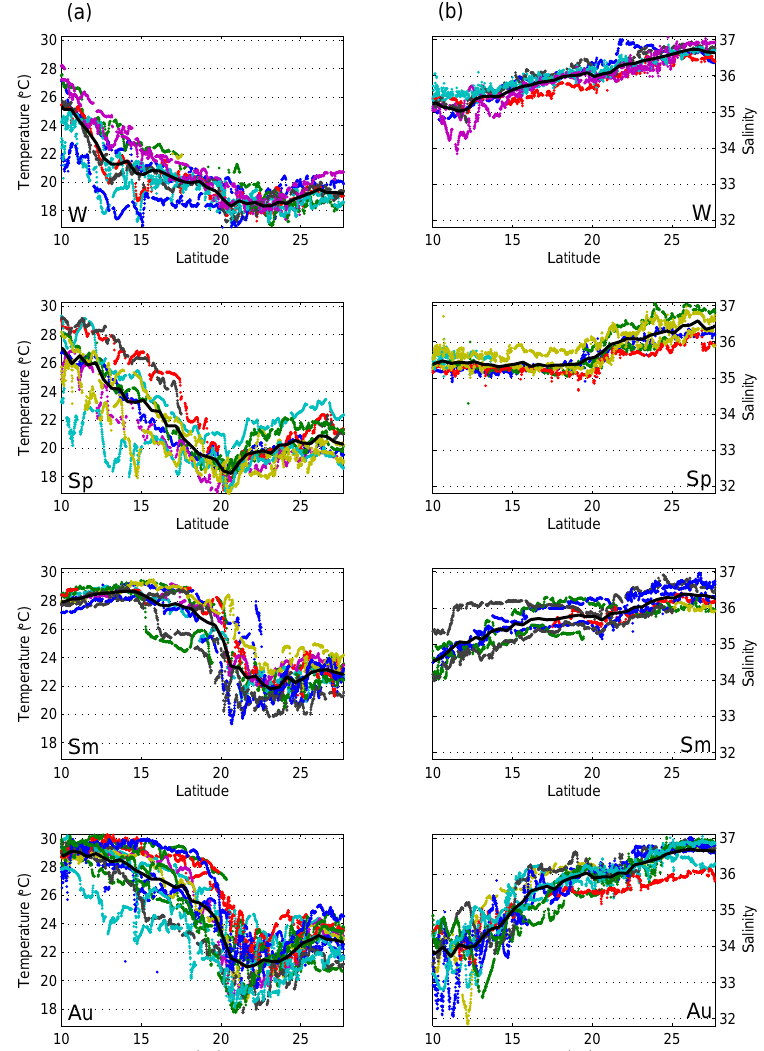
Figure 3. In situ data of column (a) SST and column (b) SSS in the Mauritanian–Cap Vert coastal region grouped by seasons: winter (W; December, January, and February), spring (Sp; March, April, and May), summer (Sm; June, July, and August), and autumn (Au; September, October, and November). The averaged values for all cruises in Table S1 are shown in black for each season including the 95% confidence limits. The color code for each cruise is indicated in Table